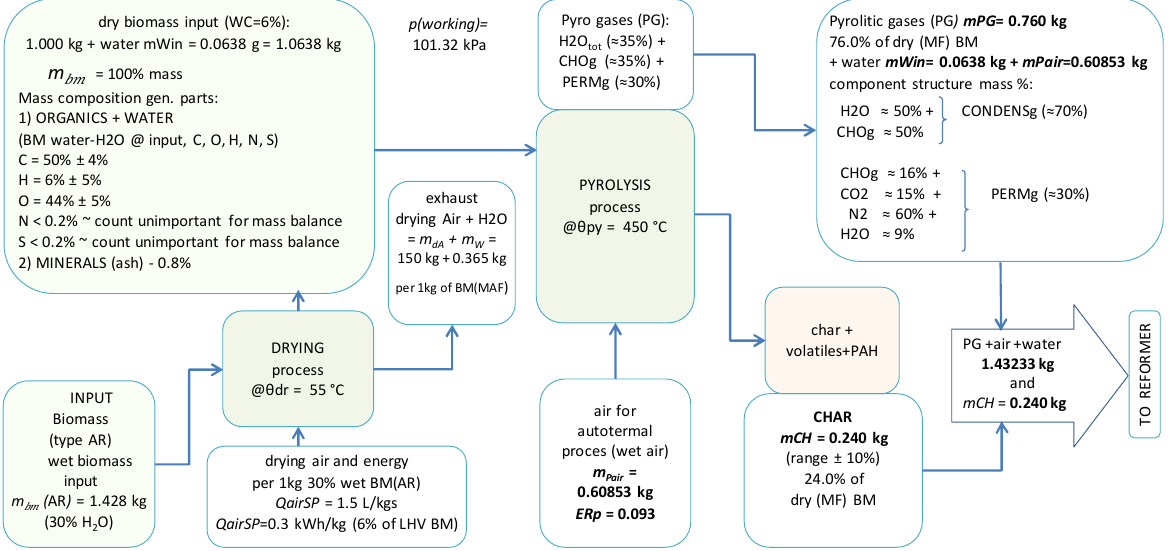
Figure 2. Block diagram of the CHPC process—part I pyrolysis; mass balance, process parameters and streams in detail; unit mass case—1 kg of air dry BM input.